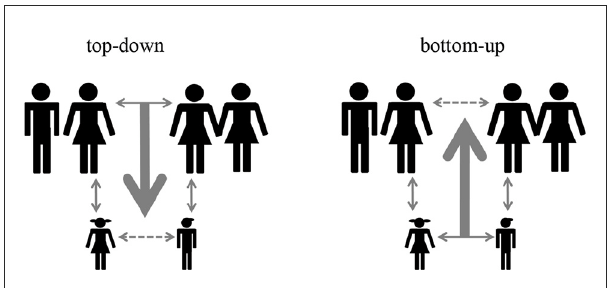
FIGURE2 Intergenerational closure results from two different mechanisms.